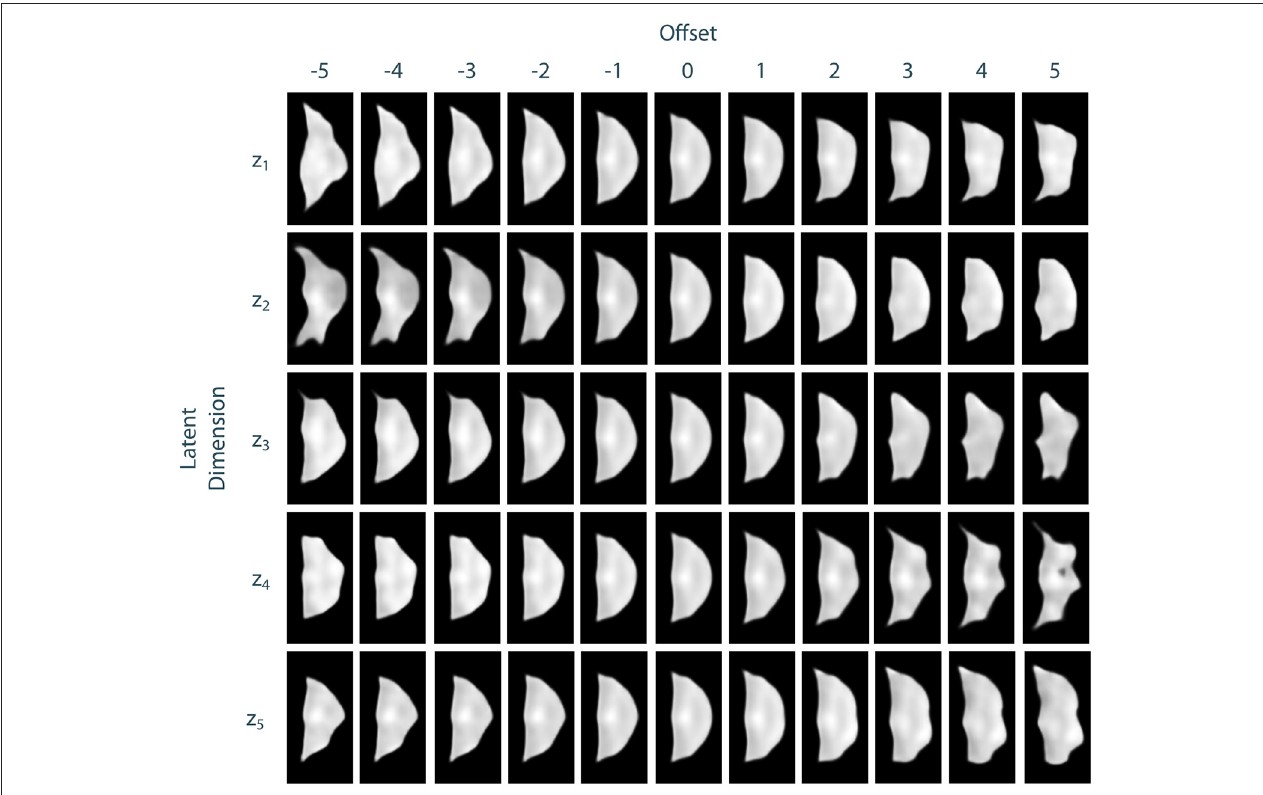
FIGURE 6 | Exploration of the leaflet autoencoder’s latent space. The median shape was manipulated by adding an offset to a specific dimension. Then, an image of this manipulated shape was synthesized. The resulting images are shown exemplarily for the first five dimensions of the latent space. Besides few outliers for extreme offsets, all shapes are realistic. The influences of the individual dimensions on the leaflet shape are consistent and complementary and the shape changes are